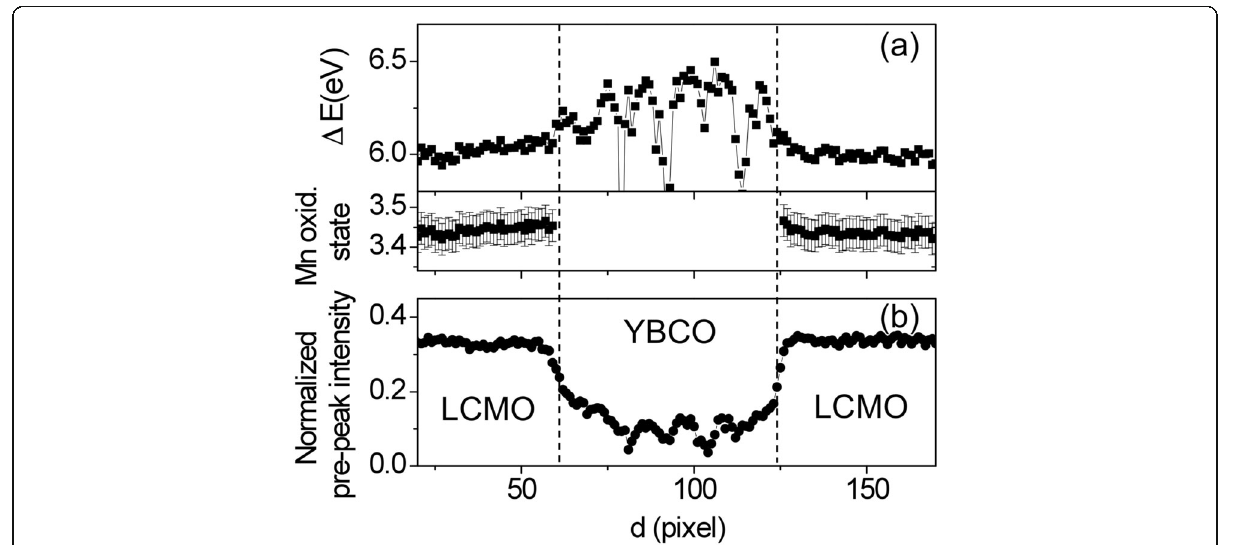
Fig. 14 a Top: For the O K edge, peak separation parameter, measured from the linescan in Fig. 13b. Bottom: Mn oxidation state in the LCMO layers, derived from the data in a . b For the same linescan, O K edge pre-peak normalized integrated intensity. Reproduced from